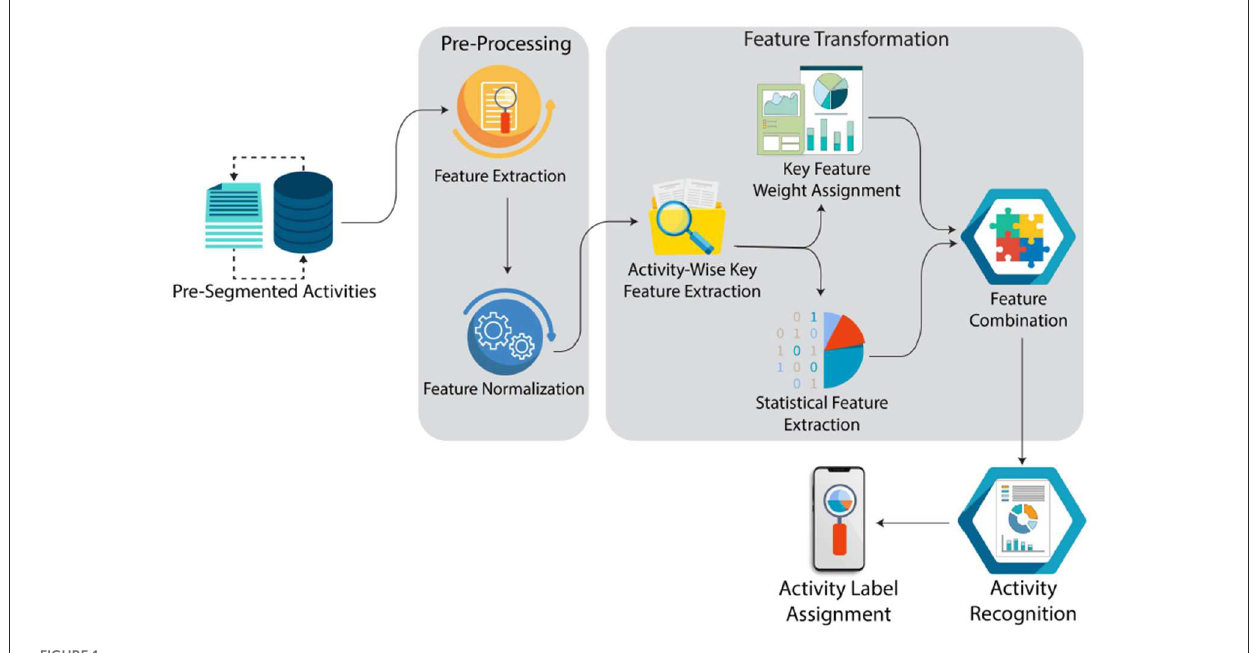
FIGURE1 Complete flow of the proposed framework.